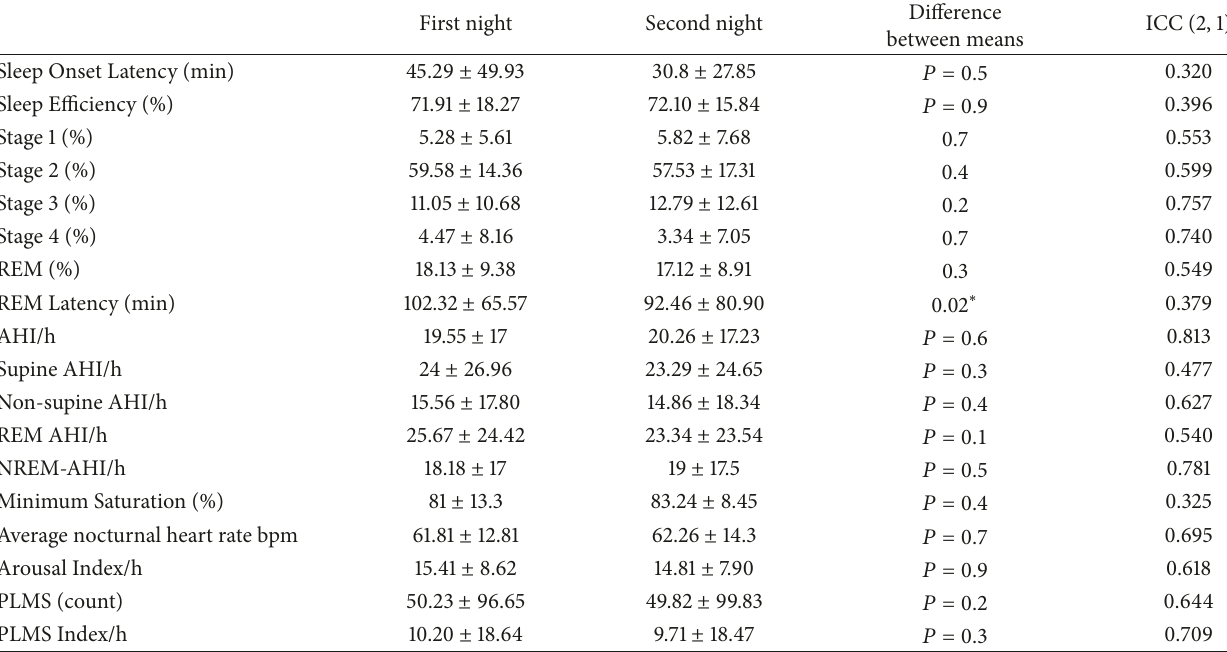
Table 3: A comparison between sleep parameters of first and second night of ambulatory sleep